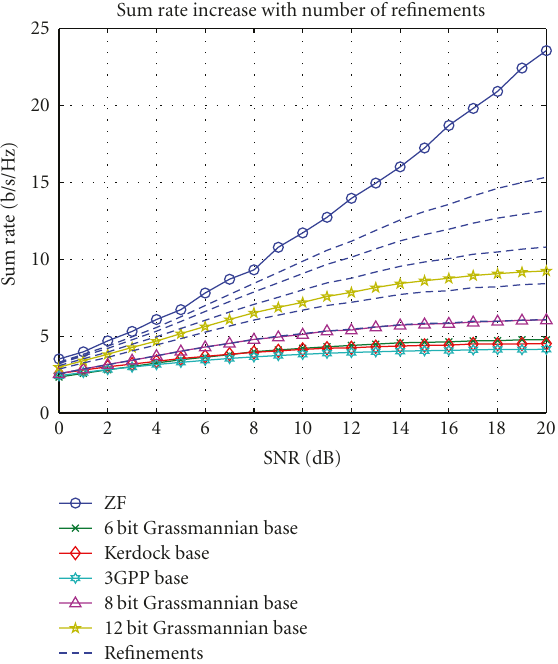
Figure 7: Sum rate performance of multiuser MIMO with N t = U = 4 for the N l = 64 Grassmannian base and ring codebook compared to various base codebooks. The sum rate increases with each refinement, with an error floor at higher SNR. The first refinement overlaps the 8 bit Grassmannian base